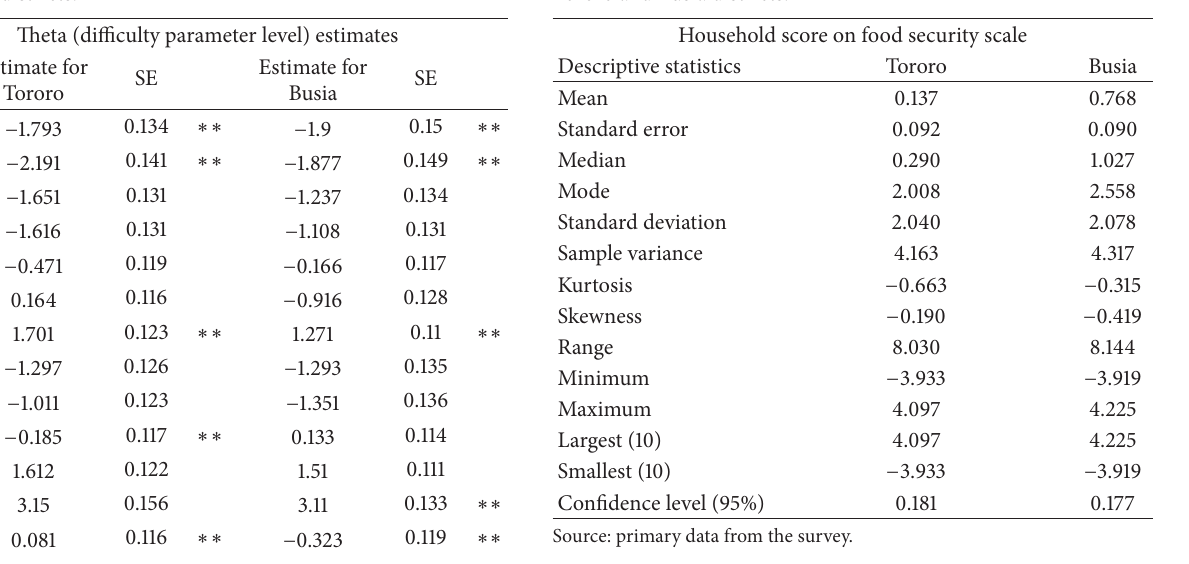
Table 3: Estimated theta coefficients of the Rasch model for Tororo and Busia districts.